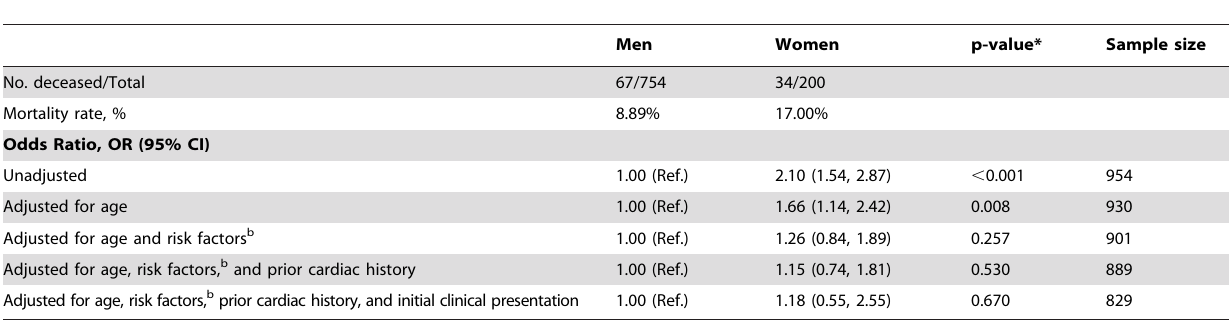
Table 3. Gender differences in in-hospital